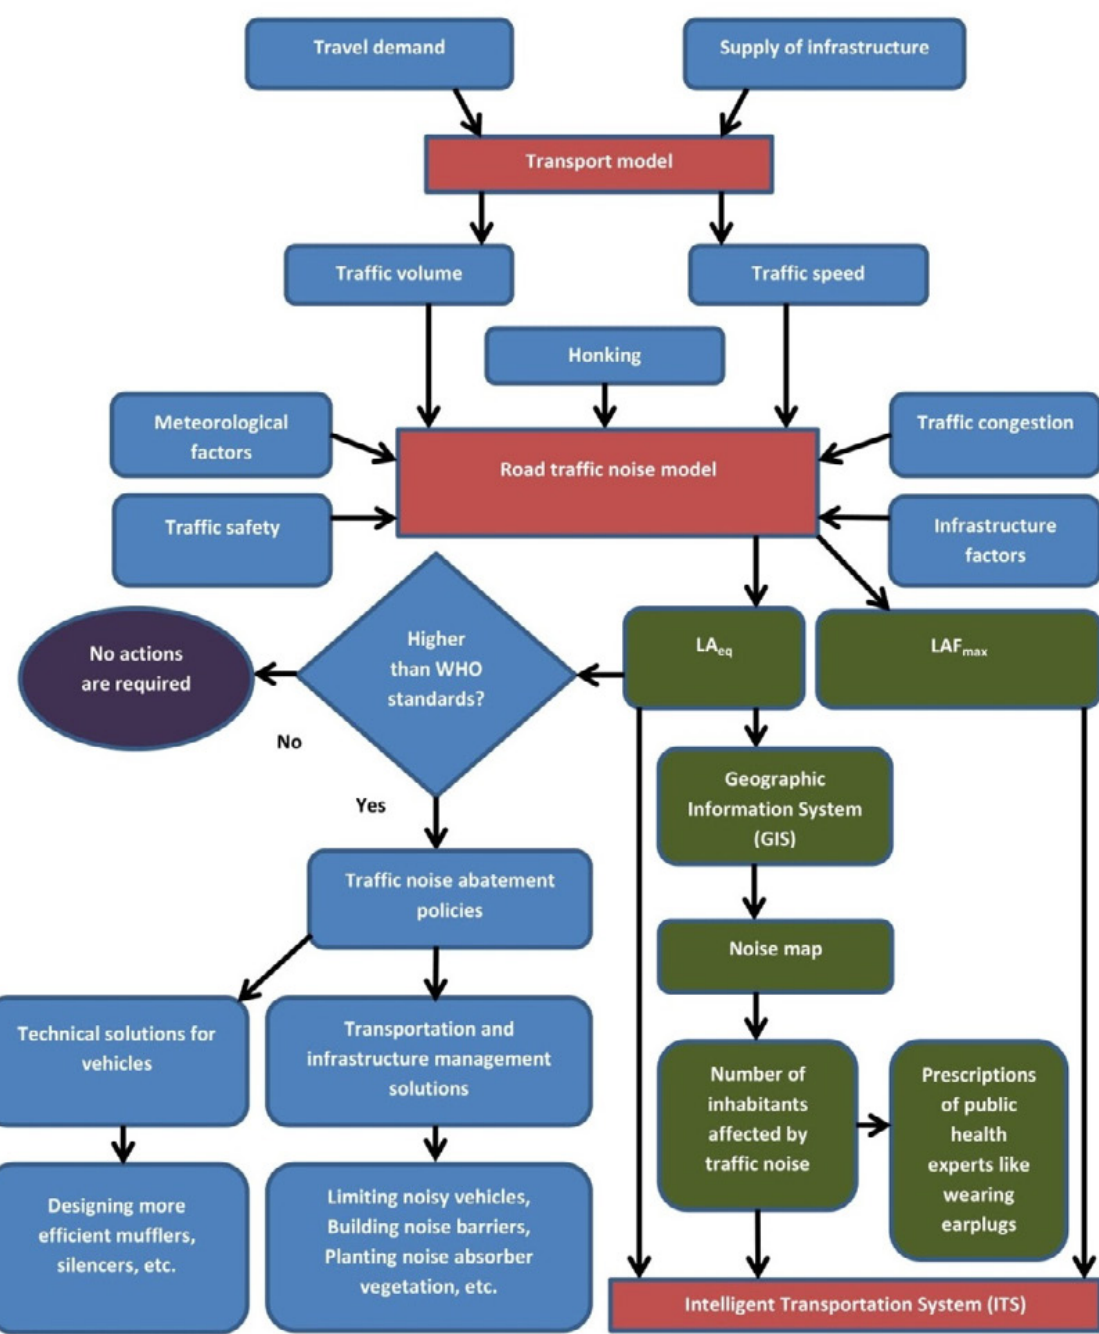
Fig. 2: Conceptual model illustrating traffic noise model with its policy and societal relevance